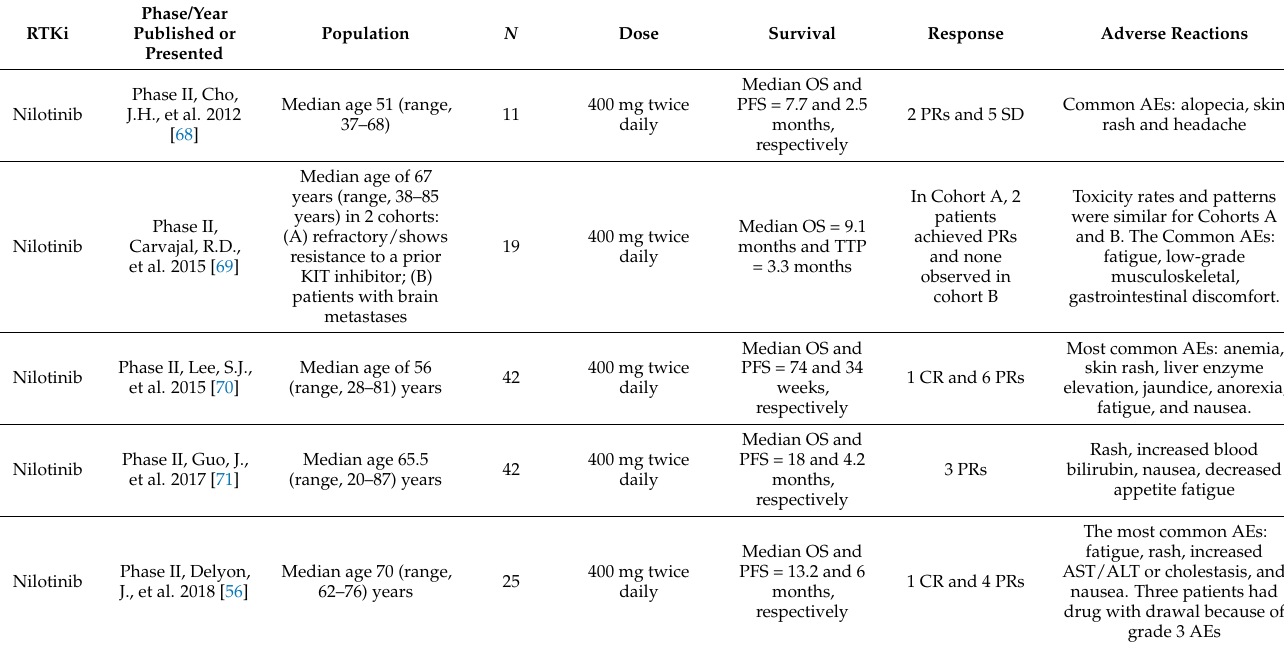
Table 3. Nilotinib monotherapy in melanoma clinical